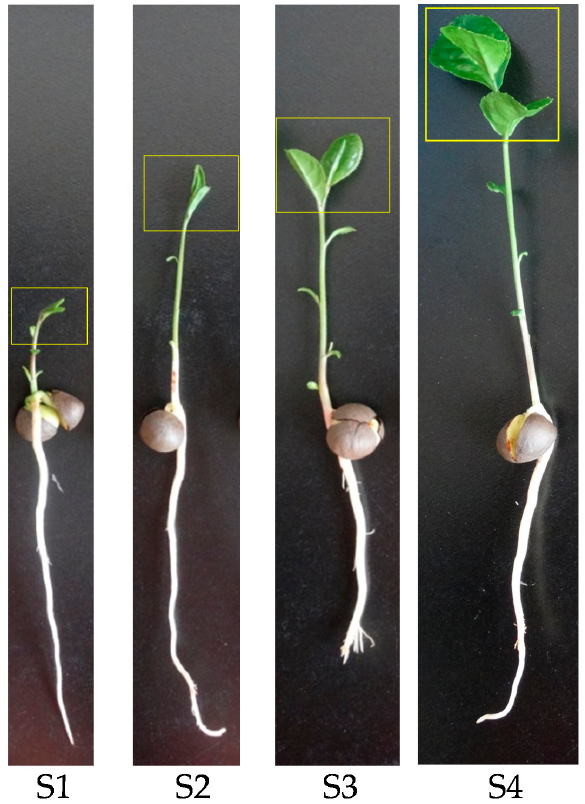
Figure 5. Tea seedlings at different developmental stages. S1 , S2 , S3 and S4 indicate the tea seedling at 20, 30, 40 and 50 d after germination respectively. Sampling sites were boxed in yellow.